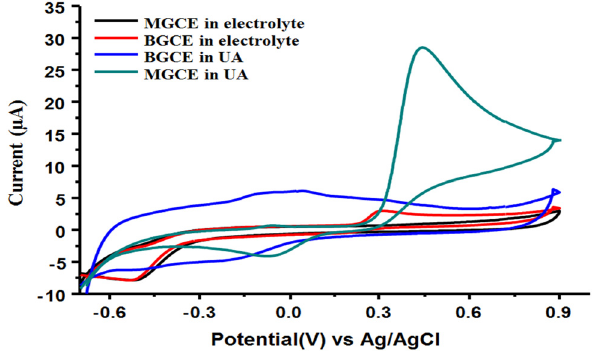
Figure 3: CV response of bare glassy carbon electrode and CuO/GCE in 0.1 M PBS pH ( 7.4